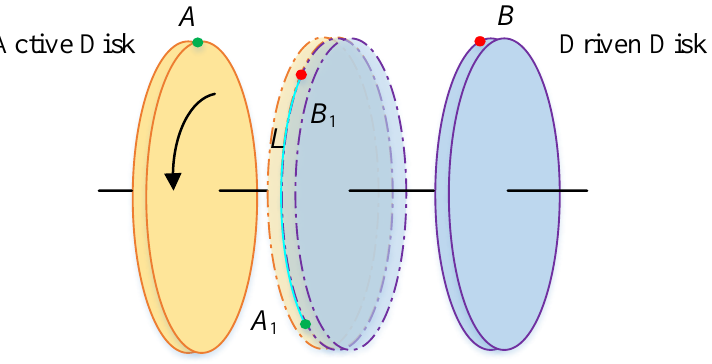
Figure 6. Sliding distance L in the course of friction clutch engagement.